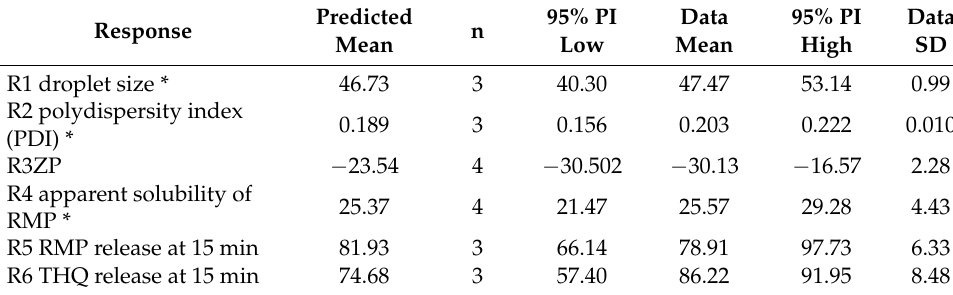
Table 6. Validation of the experimental design